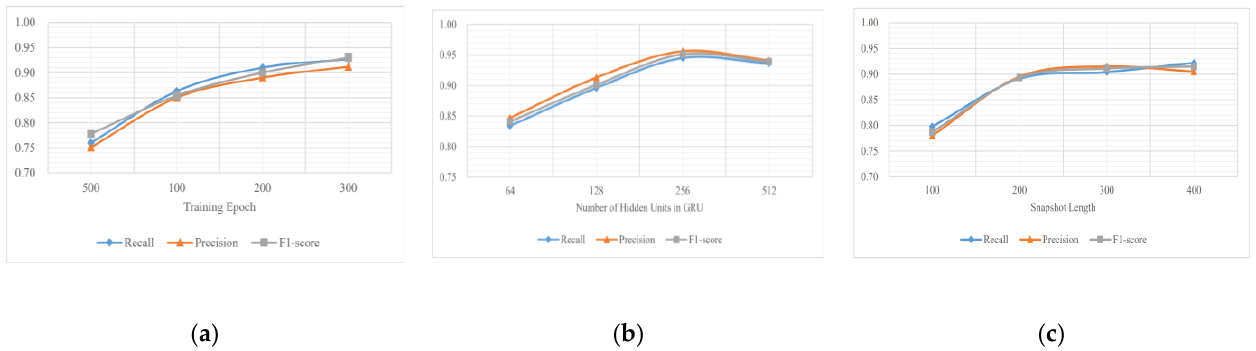
Figure 7. Parameters selection of G-TIAG. ( a ) Epochs; ( b ) Number of GRU hidden units; ( c ) Time interval of construction.